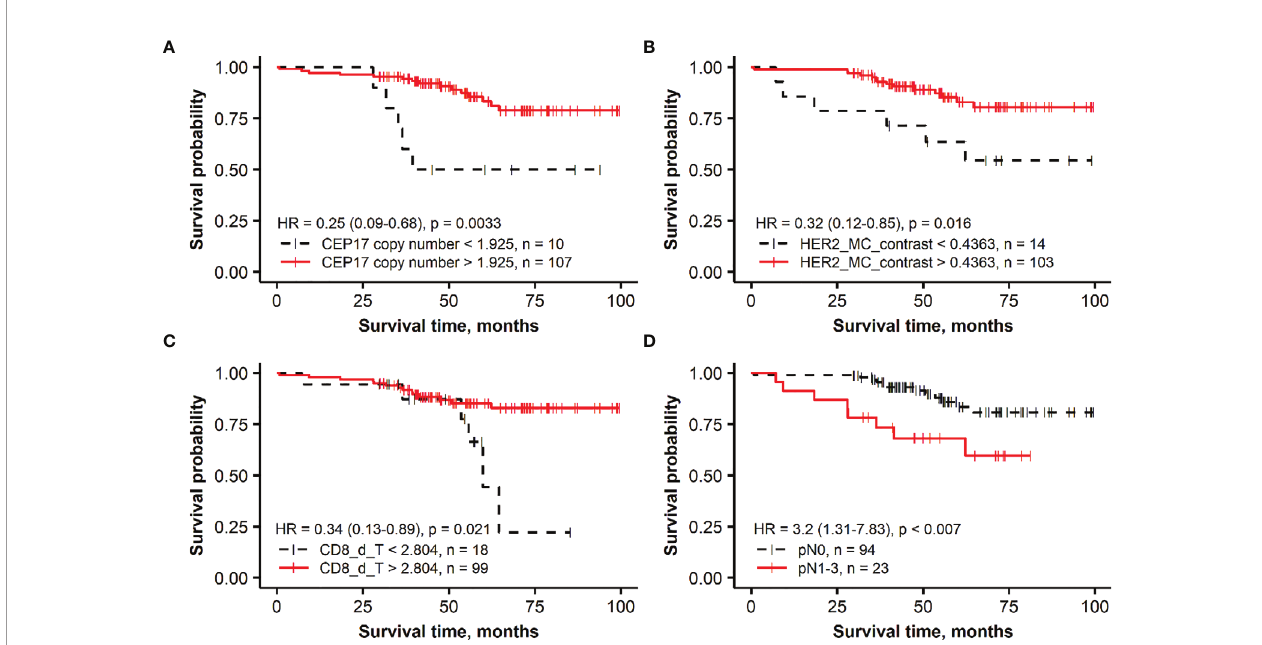
FIGURE 2 | Kaplan – Meier survival plots representing the association of overall survival in the group of patients with HER2 -ampli fi ed breast cancer with independent prognostic indicators identi fi ed by multiple Cox regression analysis: (A) CEP17 copy number, (B) membrane completeness contrast (HER2 MC contrast), (C) mean CD8 density in the tumor aspect (CD8_d_T), and (D) lymph node status (pN).